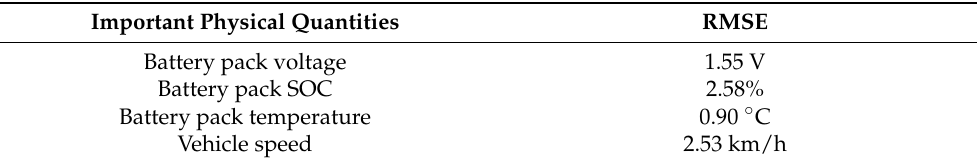
Table 2. RMSE of the simulation results.